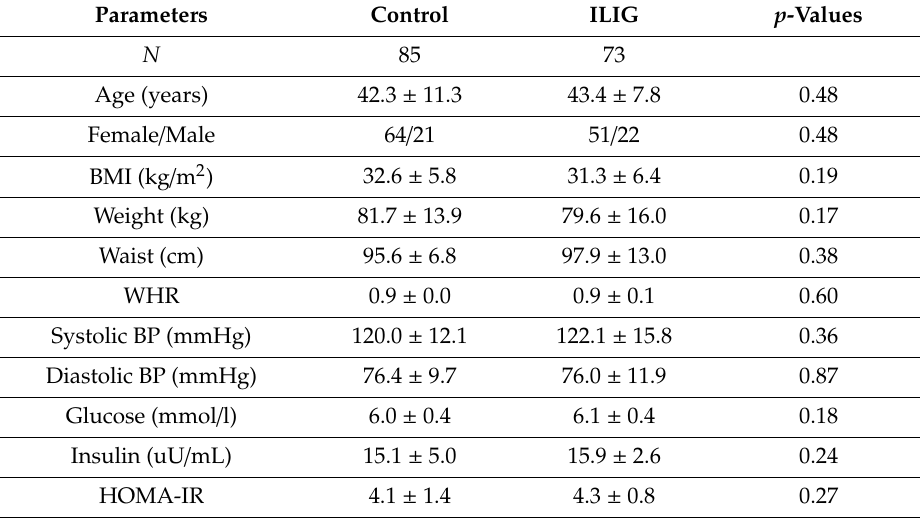
Table 2. Descriptive statistics according to